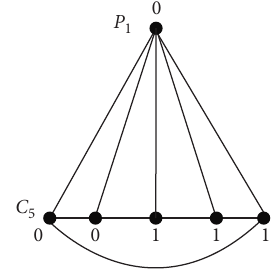
Figure 19: Logical labeling of P